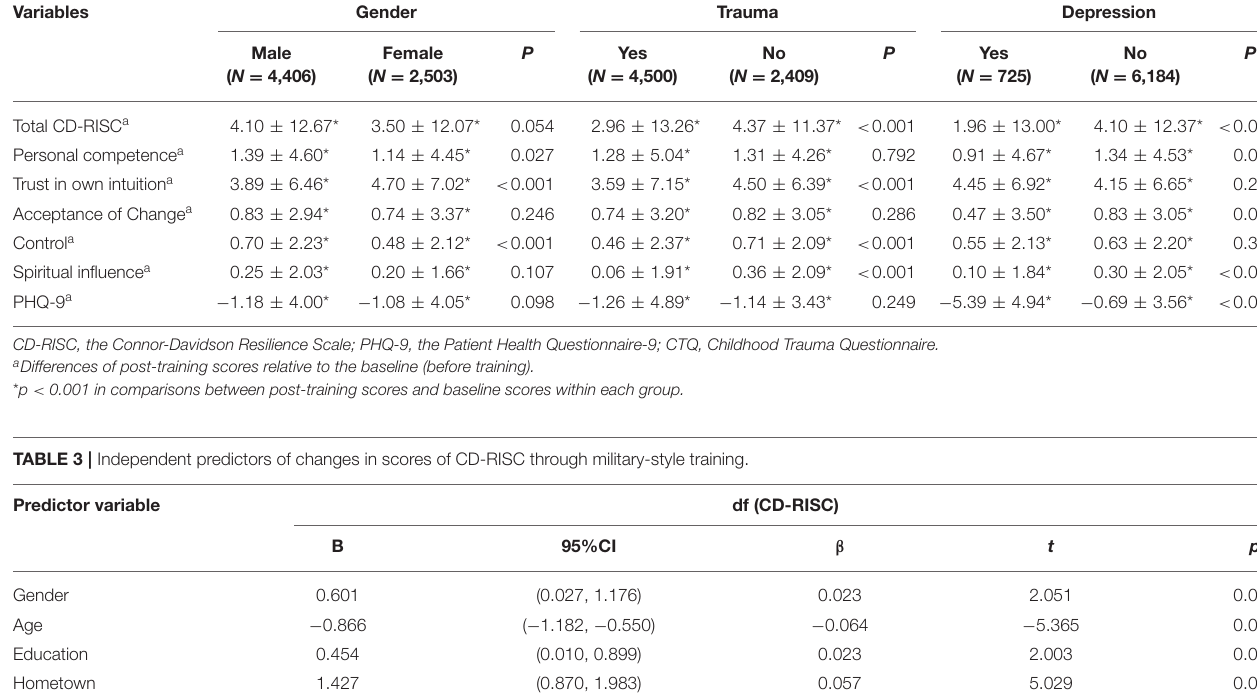
TABLE 2 | Comparisons of changes in scores of the CD-RISC and PHQ-9 in different groups through military-style training. Variables